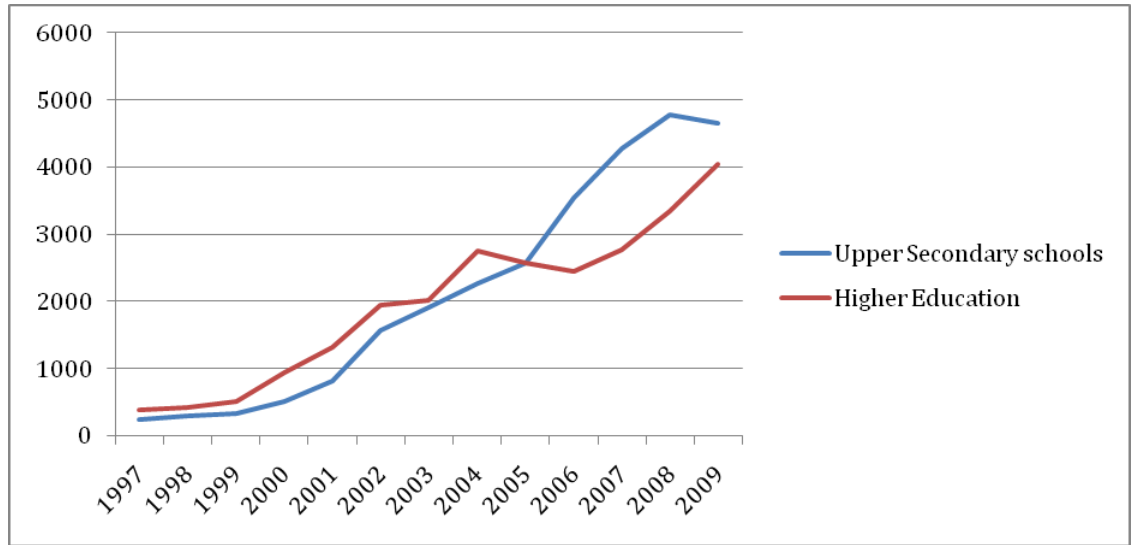
Figure 2 . Total number of students participating in distributed learning (Source: Statistics Iceland,